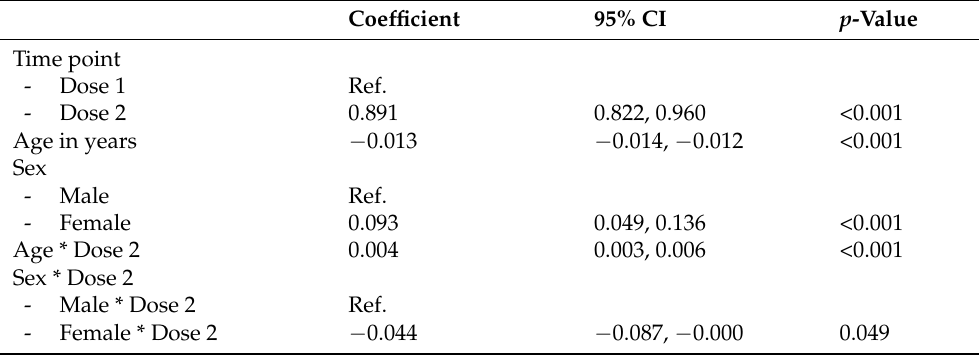
Figure 3. Spike S1-specific IgG by age in years per time point ( A , B , D ) and kinetics following the primary series of BNT162b2 vaccination in infection-naive participants up to three months follow- ing the second vaccination dose ( C ). In ( A , B , D ), fitted lines represent the linear association between IgG concentration and age from linear mixed effects regression results (Table 1), while dots repre- sent individual measurements. Results are shown separately for males (green) and females (yellow). In ( C ), boxplots show results for all participants at each time point, while dots and dashed grey lines